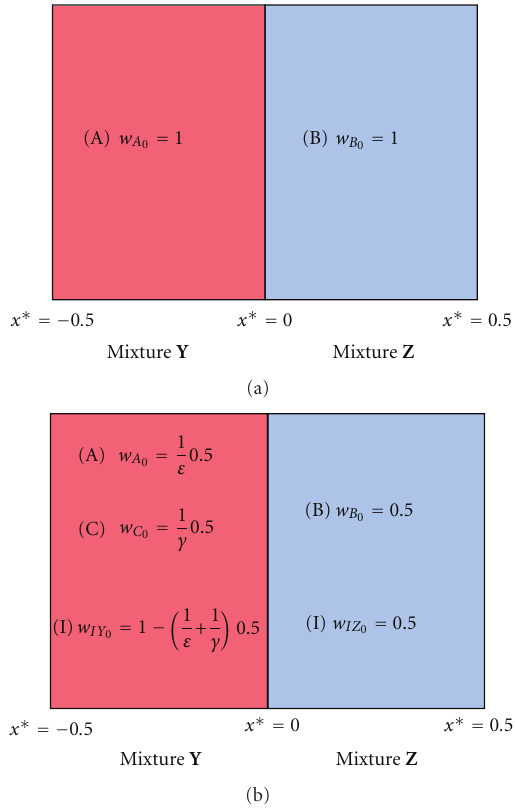
Figure 1: Initial conditions for (a) C-C and (b) C-P reaction scheme